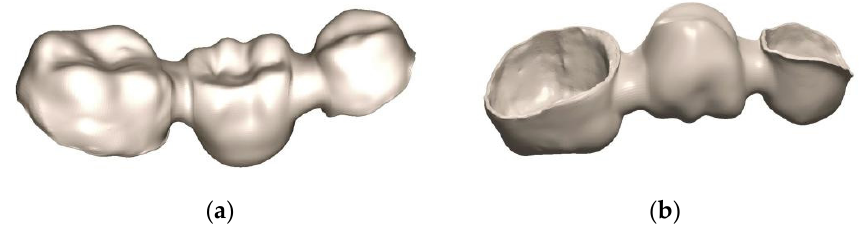
Figure 3. Complex customized dental bridge with thin walls: ( a ) Isometric view; ( b ) Inner walls.